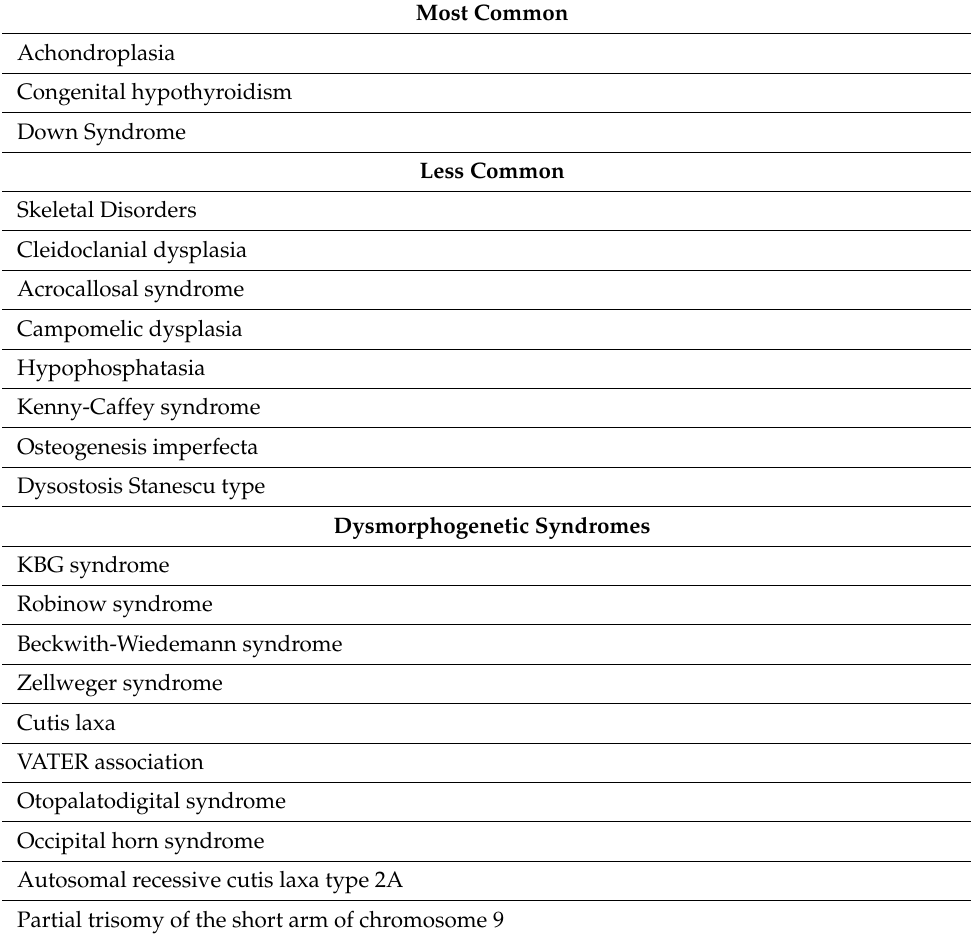
Table 4. Disorders with wide, delayed closing anterior fontanel.